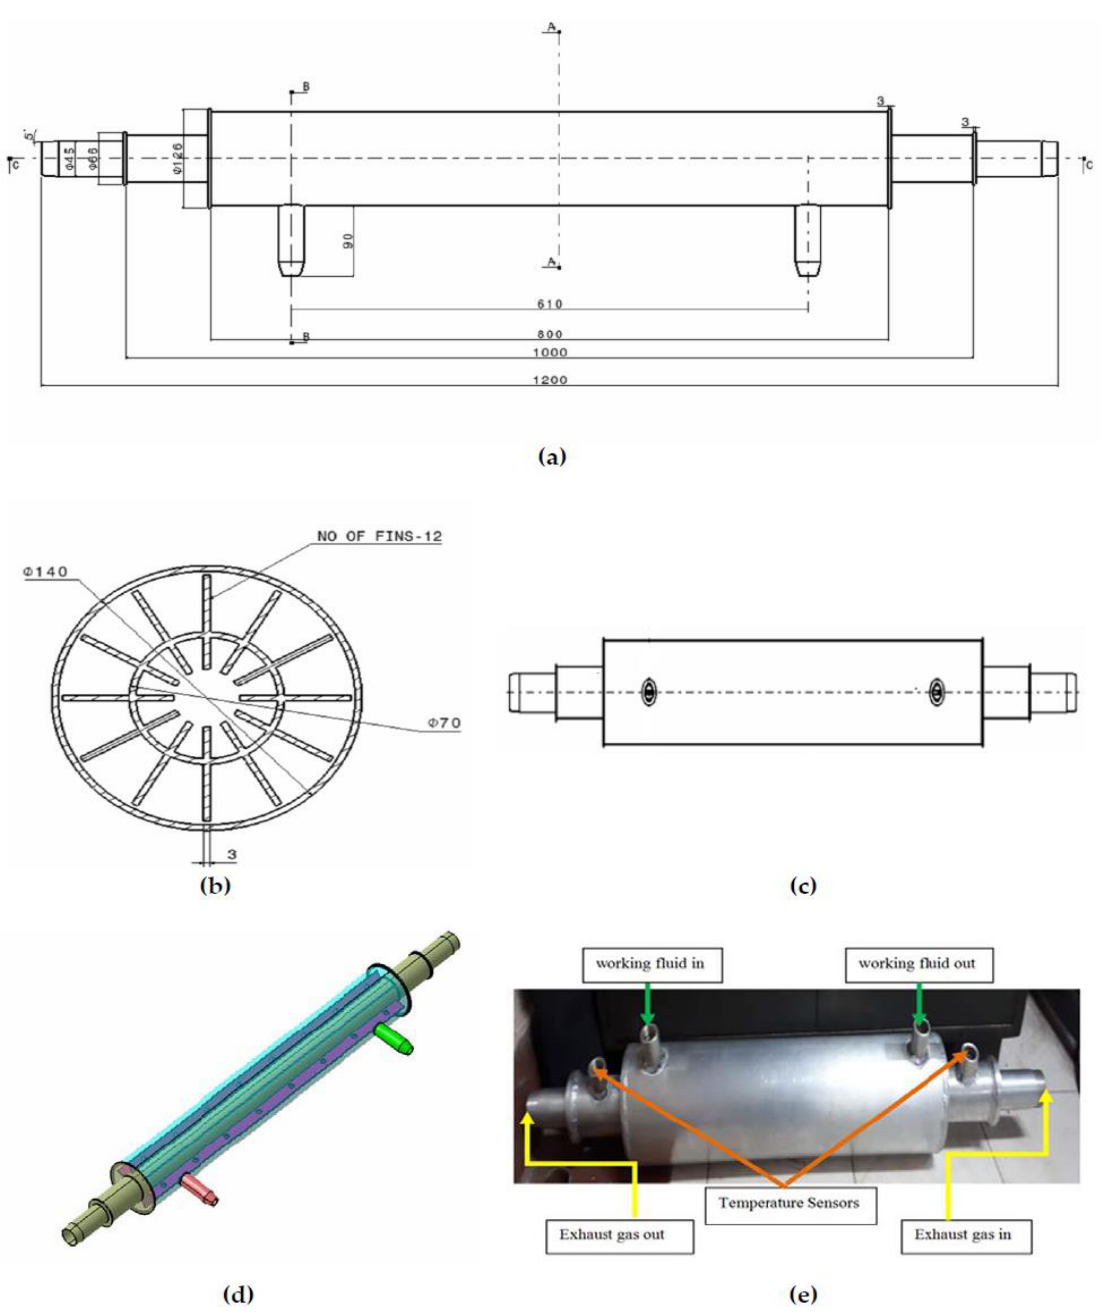
Figure 3. Schematic sketch of 2-Dimensional, 3-Dimensional and fabricated heat exchanger views of PFCHE. ( a ) Front view, ( b ) Side view, ( c ) Top view, ( d ) Isometric view, ( e ) Fabricated view.